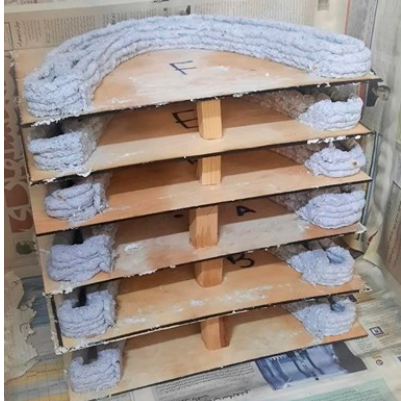
Figure 13. The printed arches growing in the chamber (Image credit: Authors).